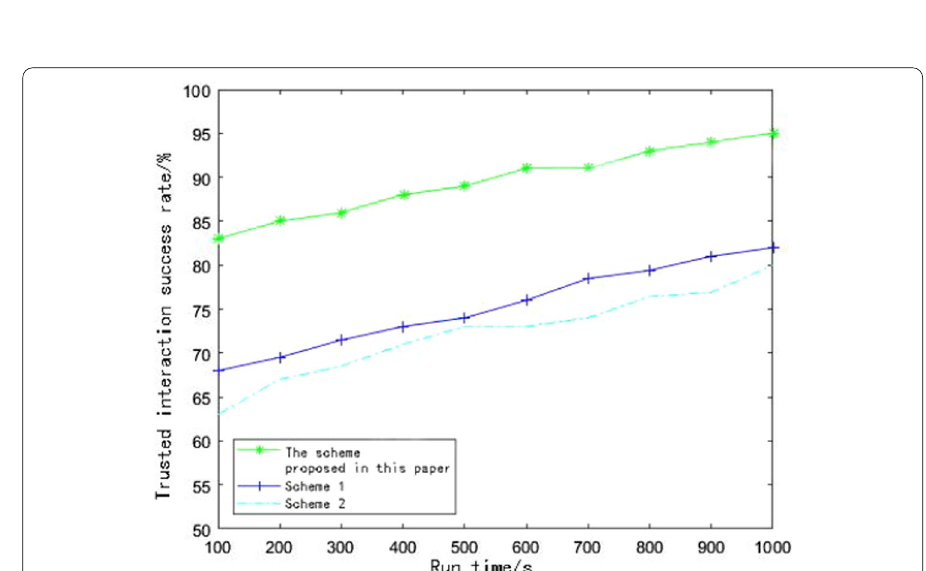
Fig. 7 The adaptability in high‑frequency‑aware network of